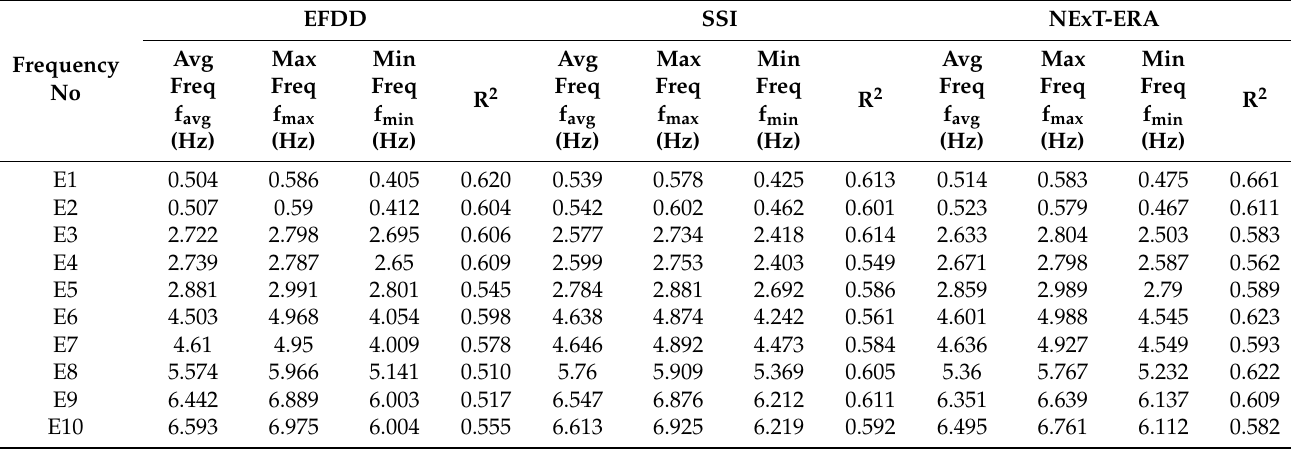
Table 3. The maximum, minimum, and average identified frequencies and their correlations with the ambient temperature.